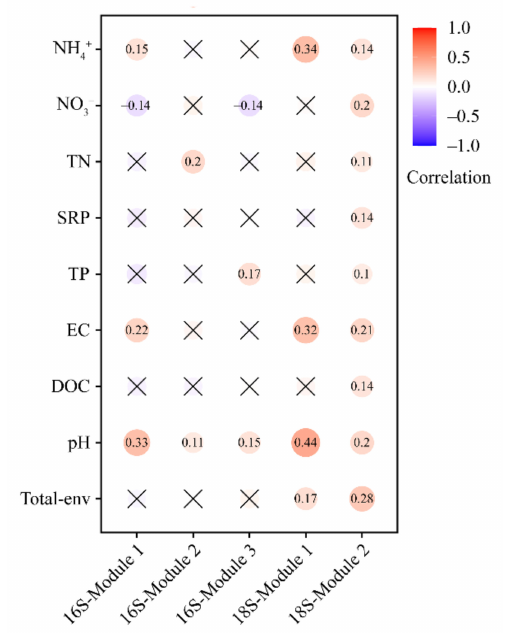
Figure 5. Spearman’s correlations between modules (>10%) and environmental variables in 16S and 18S networks. The magnitude of correlation coefficient is shown without a cross when the correlation is significant ( p <